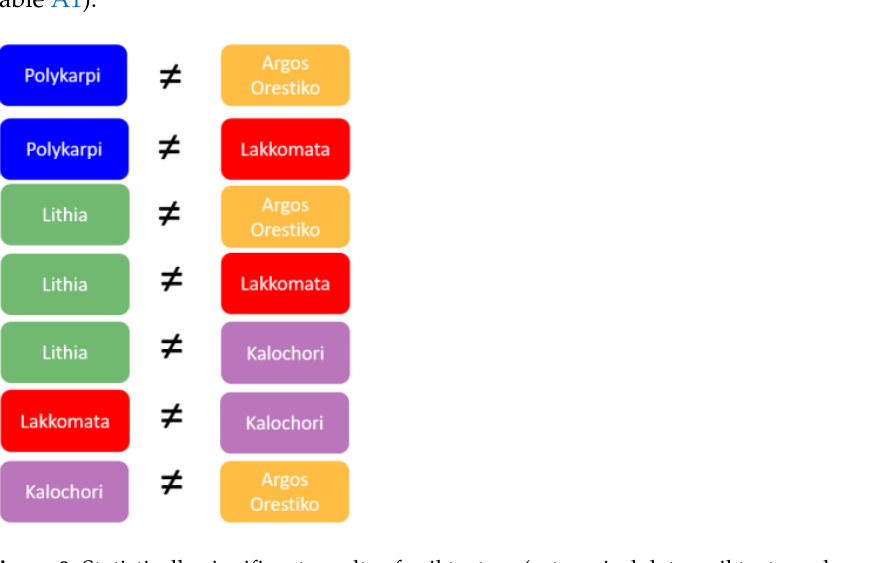
Figure 9 . Statistically significant results of soil texture (categorical data; soil texture classes).